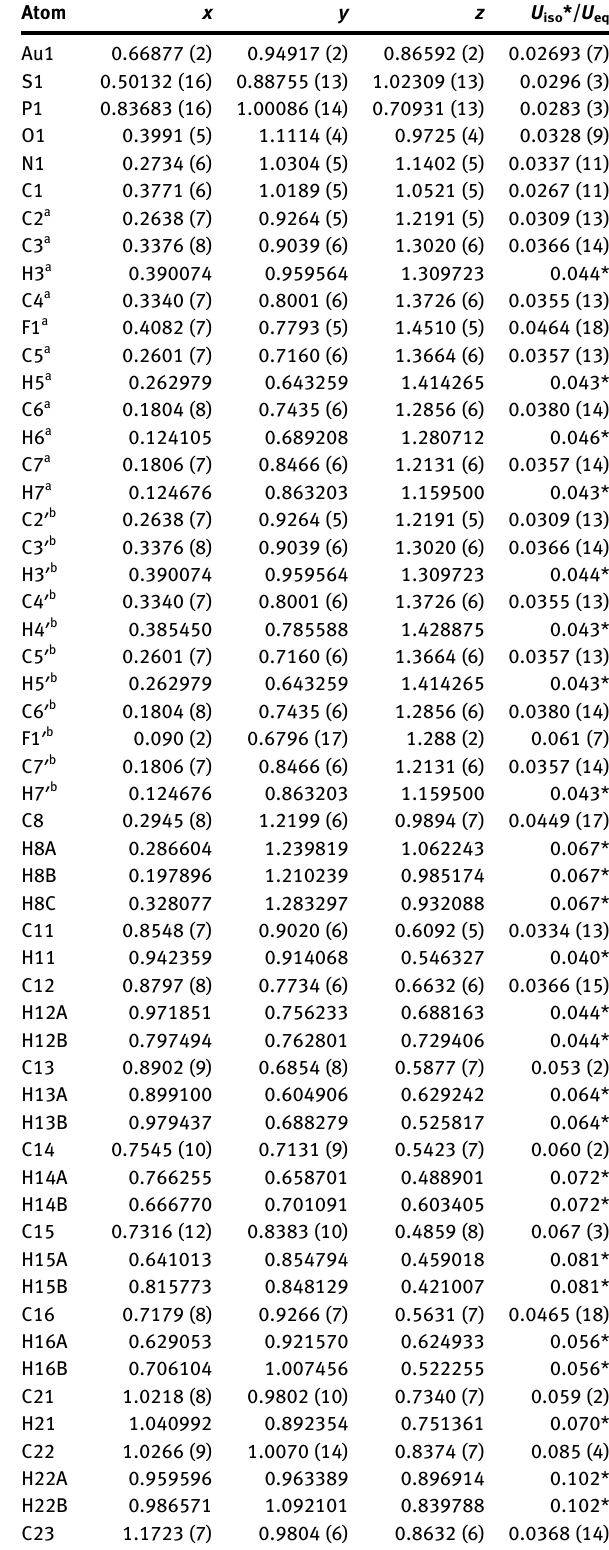
Table  : Fractional atomic coordinates and isotropic or equivalent isotropic displacement parameters (Å 